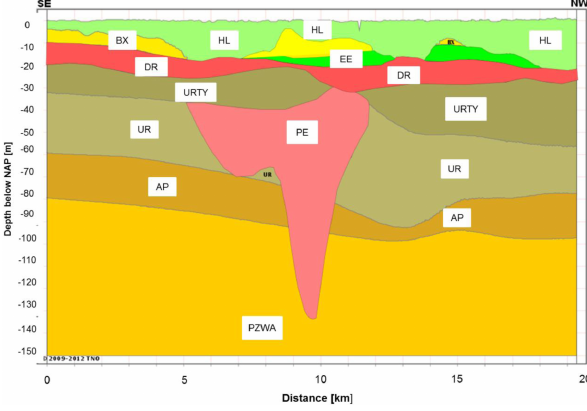
Fig. 2. SE-NW geological cross section, showing the main geo- logical units; PZWA: Peize/Waalre formation; AP: Appelscha for- mation; PE: Peelo formation (from Elsterian glaciation); UR: Urk formation; URTY: Urk-Tynje formation; DR: Drente formation (Saalian glaciation); EE: Eem formation; BX: Boxtel formation (Weichselian glaciation); HL: Holocene